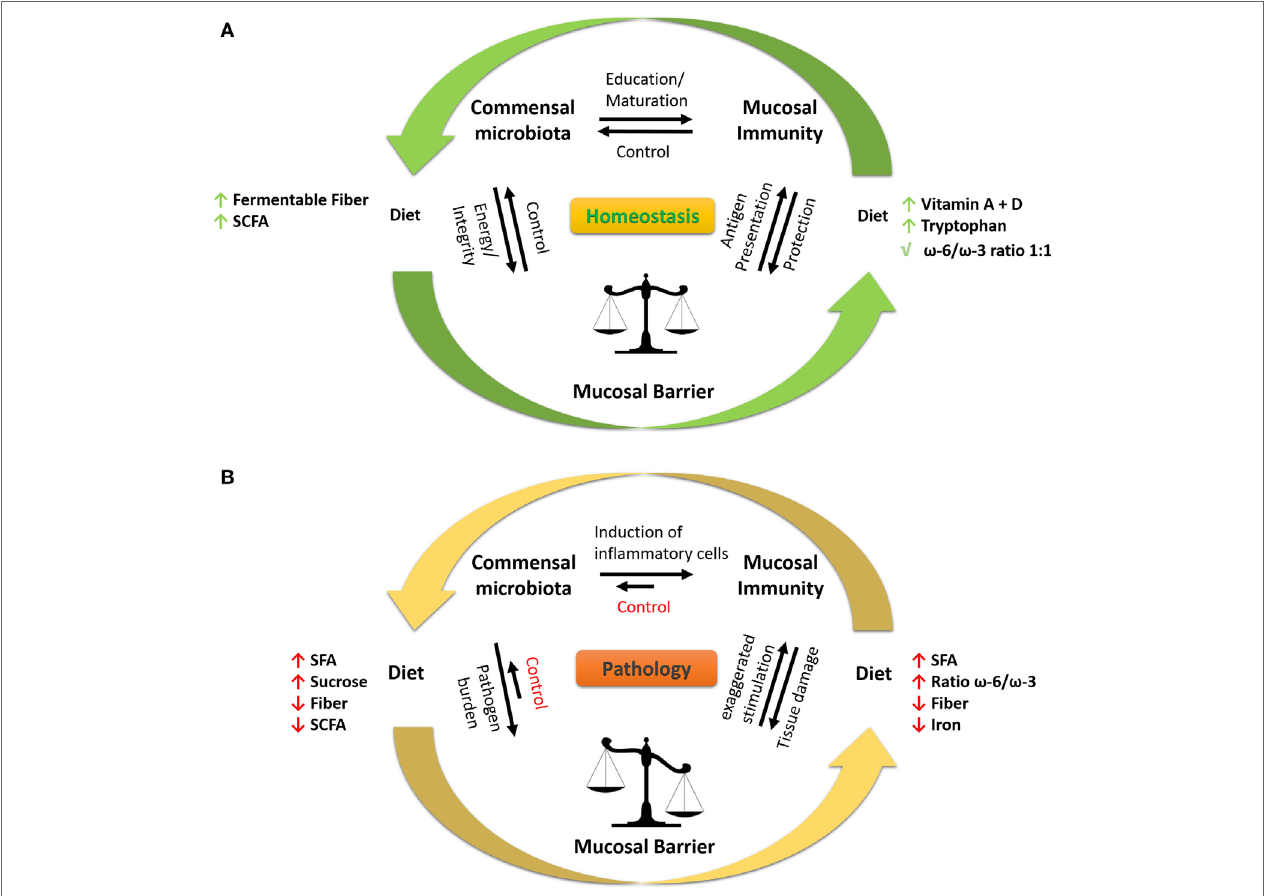
FiGURe 2 | Interaction between diet, microbiota, and immune response at mucosal sites. (A) To keep a healthy state, the local microbiota and mucosal immune system are in homeostasis at mucosal sites. The microbiota educates and promotes the maturation of the immune system by induction of pro-inflammatory and anti-inflammatory immune cells, e.g., Th17 (SFB), T regulatory cells ( Clostridia spp.), and Th1 ( Bacteroides fragilis ). Moreover, the immune system surveys microbial activities (e.g., antigen sampling at the mucosal barrier) and responds in a controlled fashion by producing, e.g., antimicrobial peptides, sIgA to prevent tissue damage. The integrity of the mucosal barrier is sustained by bacteria-produced metabolites (e.g., SCFA) such as butyrate resulting in high expression of tight- junction proteins and mucus production, thereby restricting interaction of microbes to the lumen and luminal epitheliums. The diet is involved in all processes, serving the microbiome with fermentable fibers and the immune system and epithelium with essential nutrients, e.g., vitamins and minerals. (B) During pathological conditions, such as inflammatory bowel disease and asthma, the homeostasis at the mucosal barrier is disrupted. A westernized diet, i.e., high in SFA, high ω -6/ ω -3 ratio, high sucrose and iron (oral iron supplements), and low in fiber promotes inflammation and growth of pathogenic/pathobiont (disease causing) bacteria in the gut. The microbiota, which is rich in non-beneficial bacteria, favorably induces the maturation of pro-inflammatory immune cells, leading to uncontrolled inflammation resulting in tissue damage of the mucosal compartment. The damaged mucosa and shifted immune response fail to control the microbiota, which exaggerates the pathophysiological state. Under certain conditions, bacteria-derived LPS enters the systemic circulation and further stimulates the immune system toward a pro-inflammatory state. Abbreviations: LPS, lipopolysaccharide; SCFAs, short-chain fatty acids; SFAs, saturated fatty acids; SFB, segmented filamentous bacteria; sIgA, secretory immunoglobulin A; ω -6/ ω -3, omega-6/omega-3 fatty acid ratio; Th, T